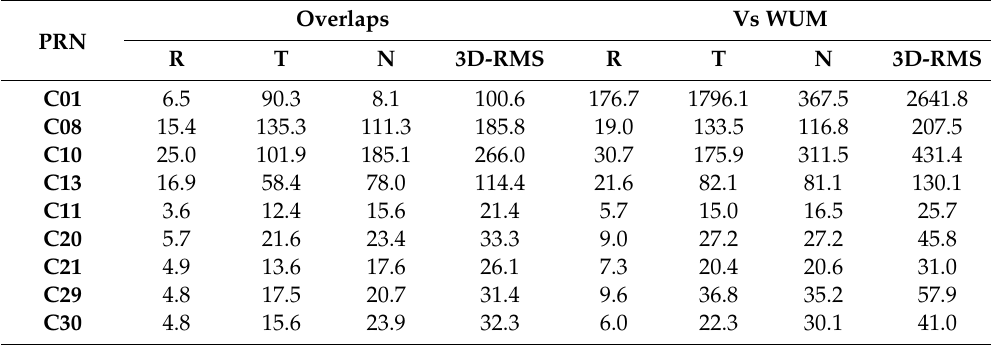
Table 6. The median RMS of 9-day solutions (Unit: